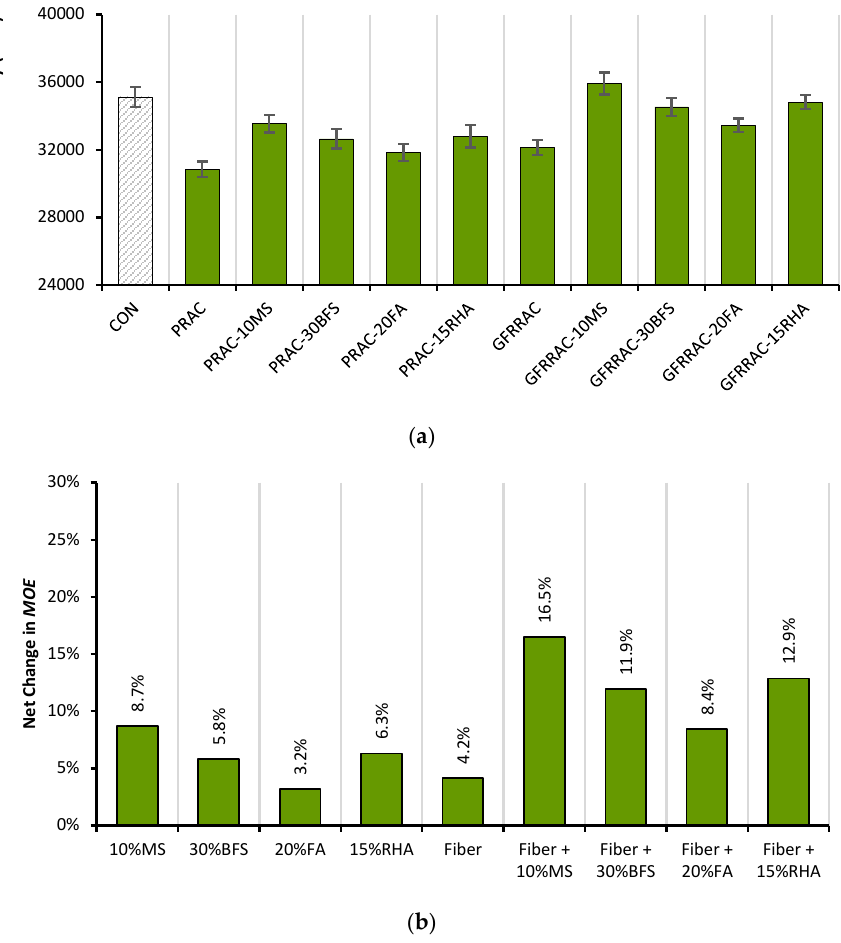
Figure 9. Modulus of elasticity (MOE): ( a ) MOE of PRAC and GFRRAC mixes with varying mineral admixture; ( b ) net change in MOE of RAC due to incorporation of mineral admixtures and glass fibers.